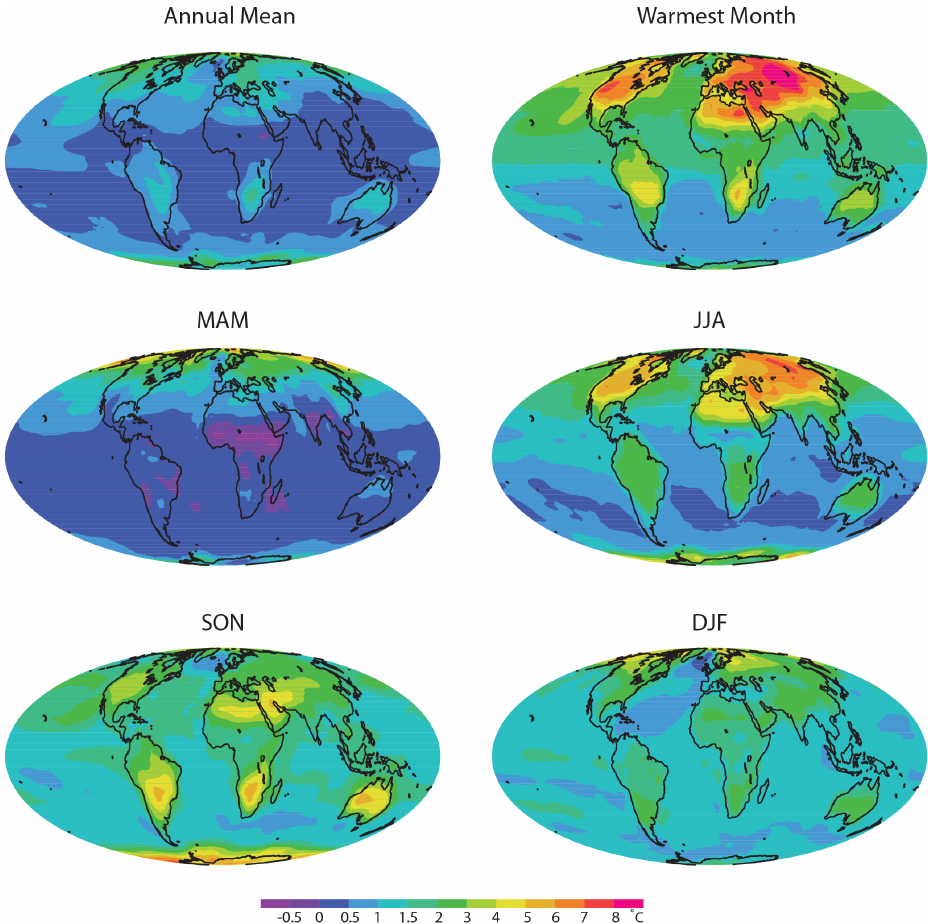
Figure 5. Spatial differences in LIG maximum temperatures ( ◦ C) compared to pre-industrial for DJF, MAM, JJA and SON temperatures following the compilation-warmest-periods (CWP)